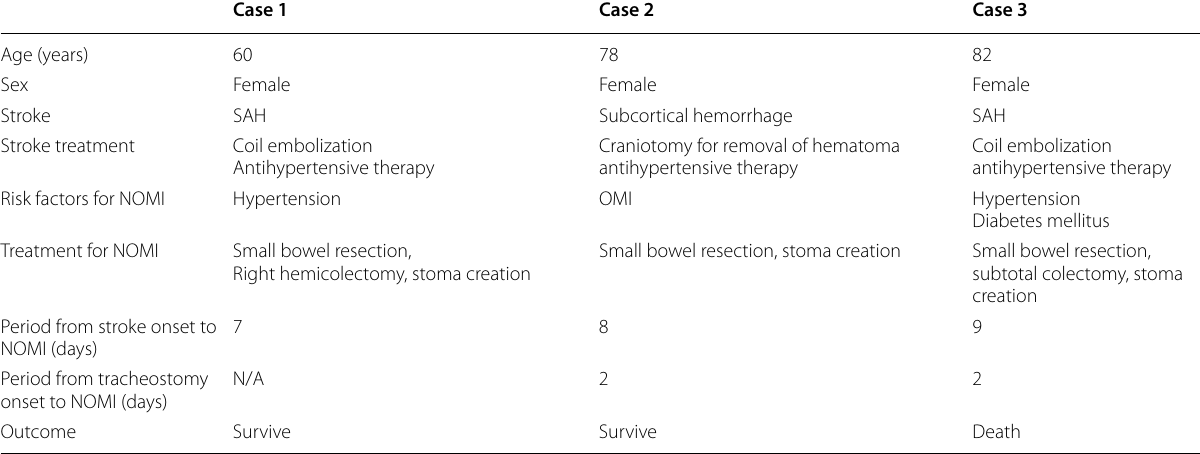
Table 1 Clinical features of patients with NOMI during treatment for acute